Question: From the figure, is the trend upward or downward?
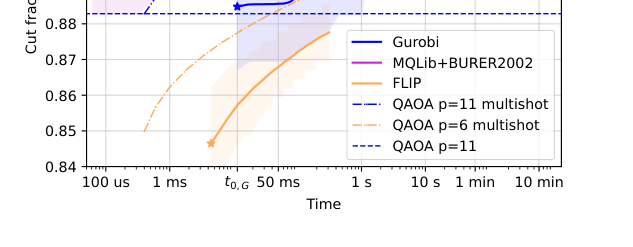
Answer: decreasing